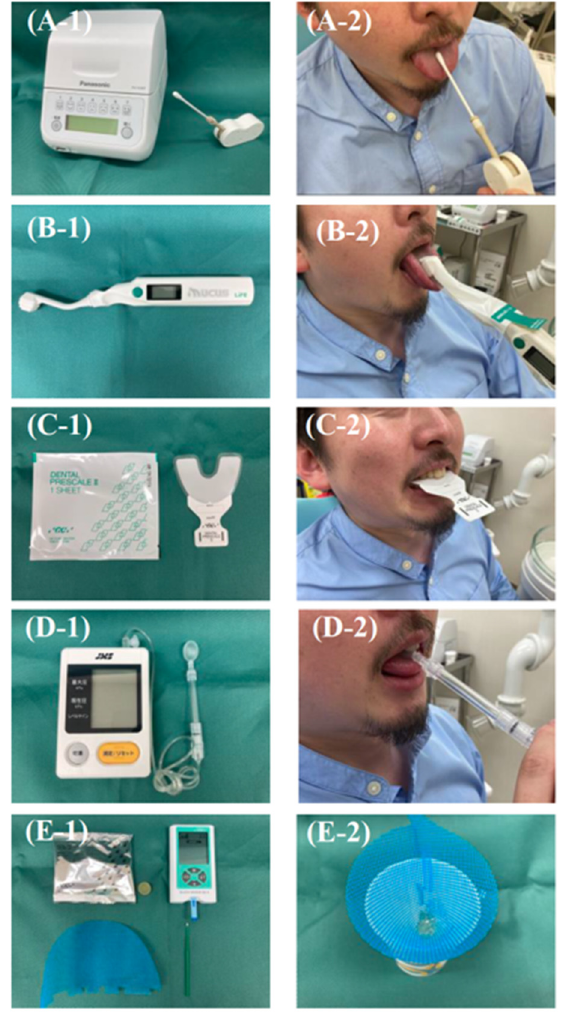
Figure 4. Testing instruments for oral function assessment and their use. ( A-1 ) Bacterial counter. ( A-2 ) Specimen being collected from the dorsum of the tongue. ( B-1 ) Oral moisture checker. ( B-2 ) Measuring oral moisture on the dorsal surface of the tongue. ( C-1 ) Dental prescale. ( C-2 ) Measurement of occlusal force using dental prescale. ( D-1 ) JMS tongue pressure measuring instrument. ( D-2 ) Measurement of tongue pressure using a probe. ( E-1 ) Gluco Sensor GS-II. ( E-2 ) After chewing and filtering gummy jelly.